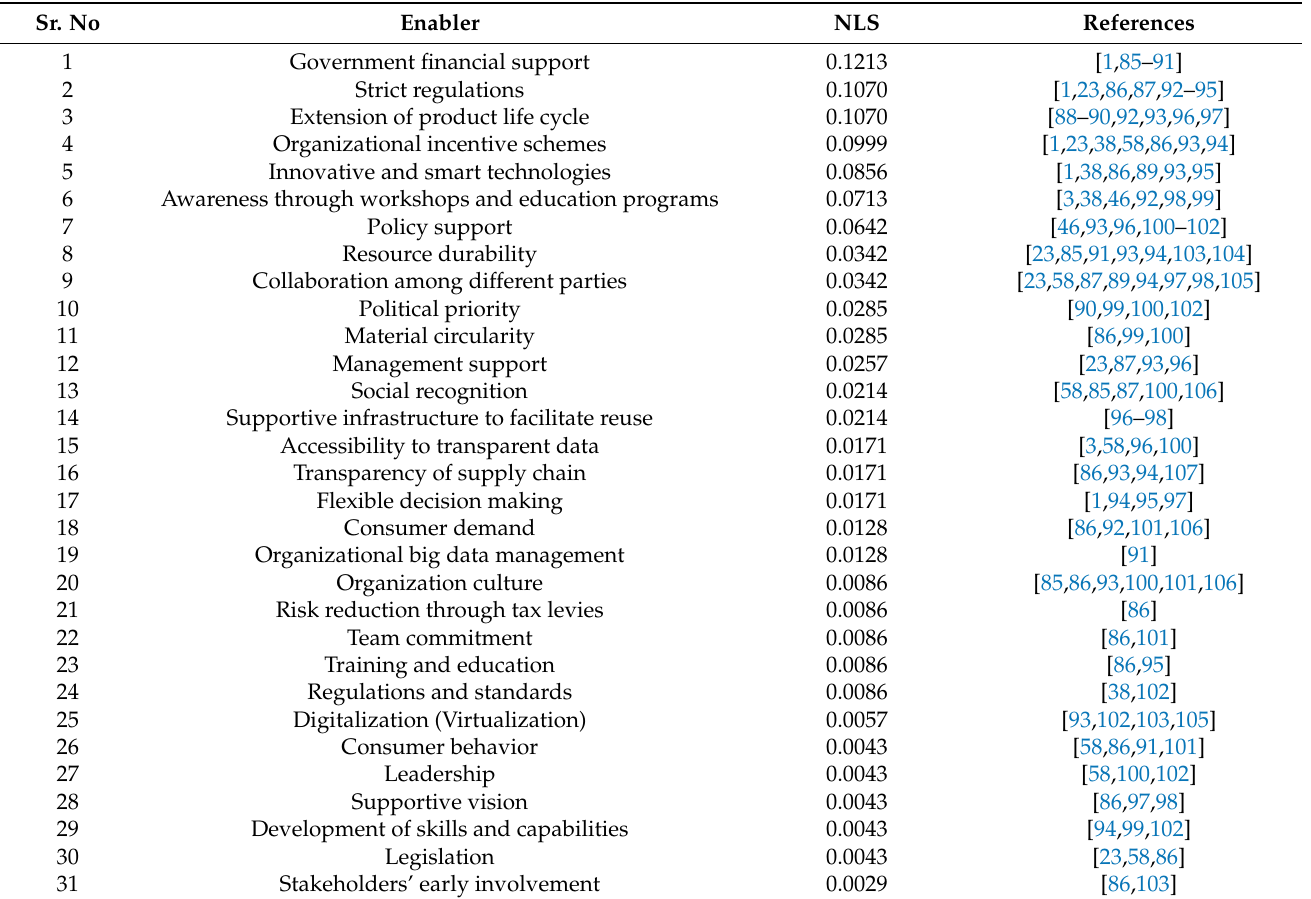
Table 1. Enabler’s identification via Literature